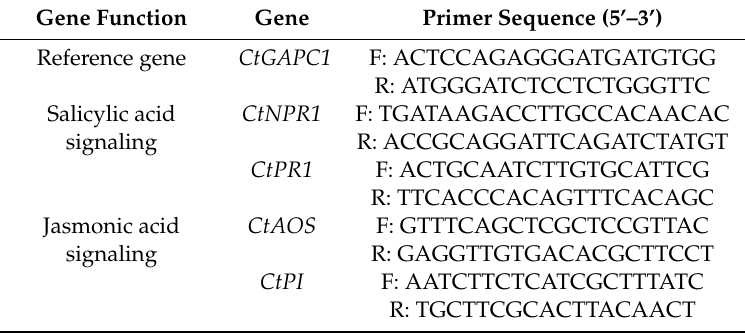
Table 1. Primers used in present